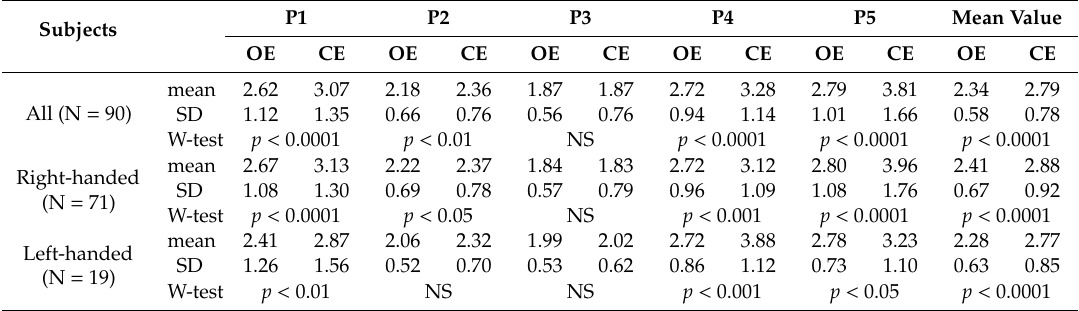
Table 2. Postural control of the